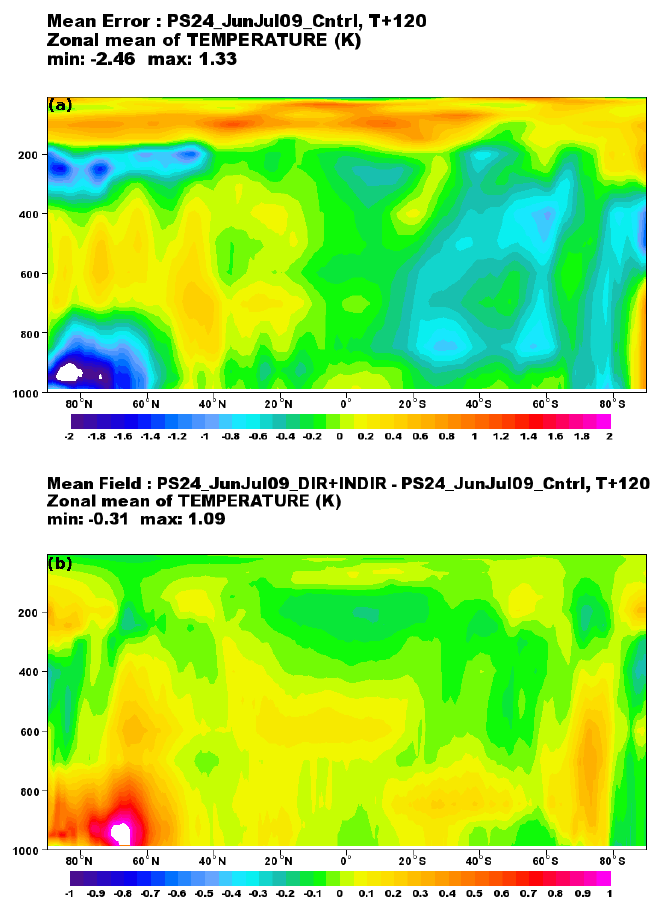
Fig. 14. Zonal mean temperature at T +120 : (a) CNTRL error and (b) AER DIR INDIR-CNTRL difference.